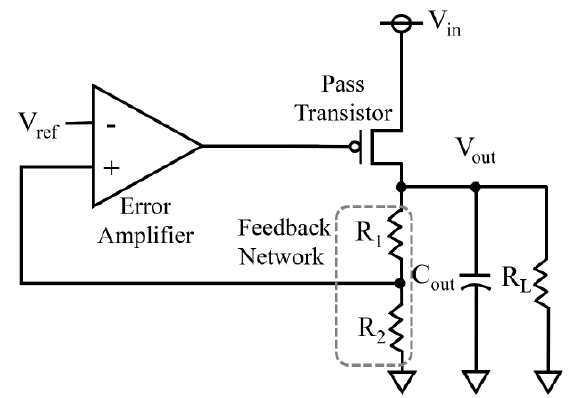
Figure 7. The basic structure of a conventional ALDO [40].